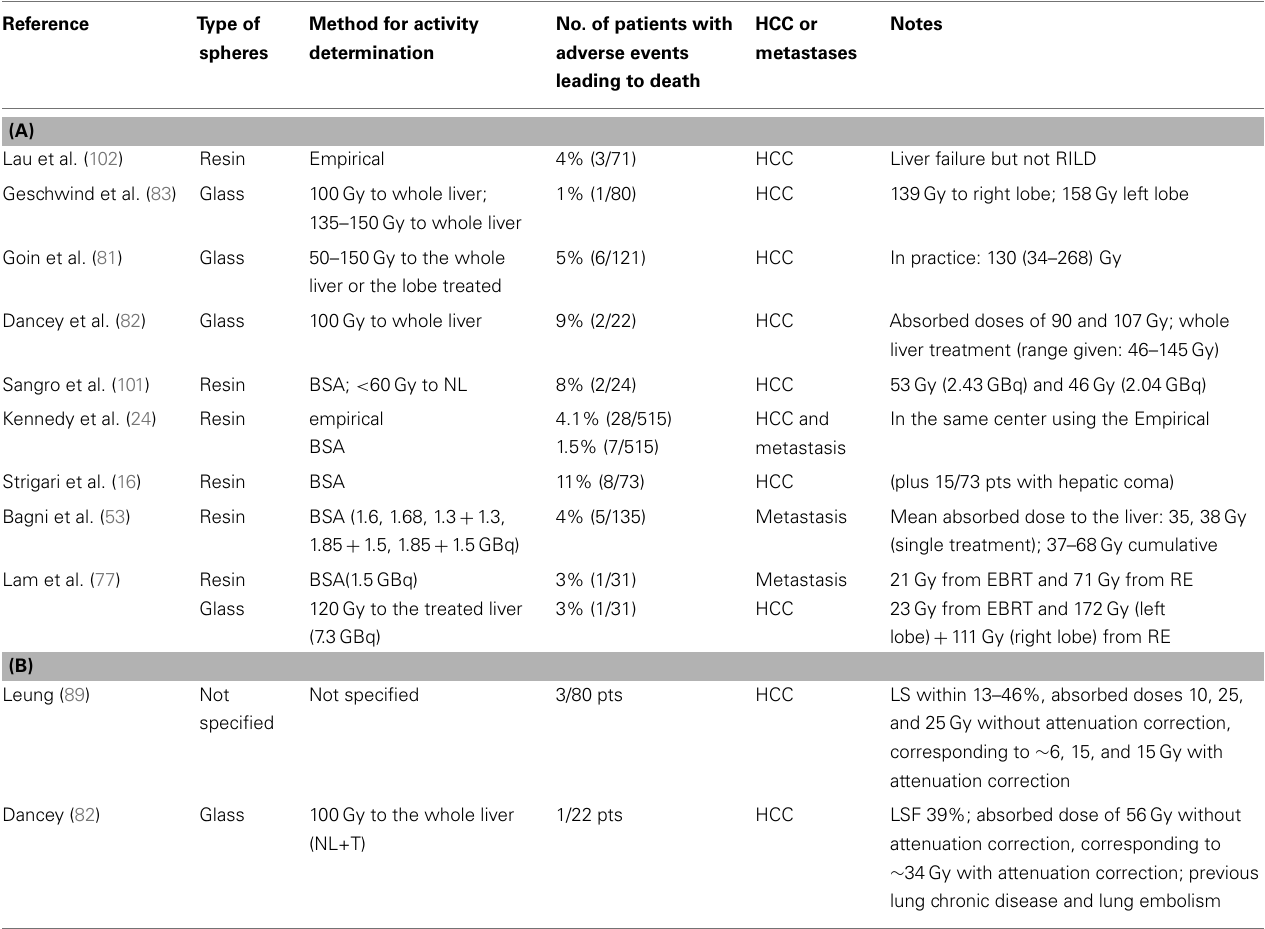
Table 4 | (A) Fatal events due to liver failure; (B) Fatal events due to radiation pneumonitis